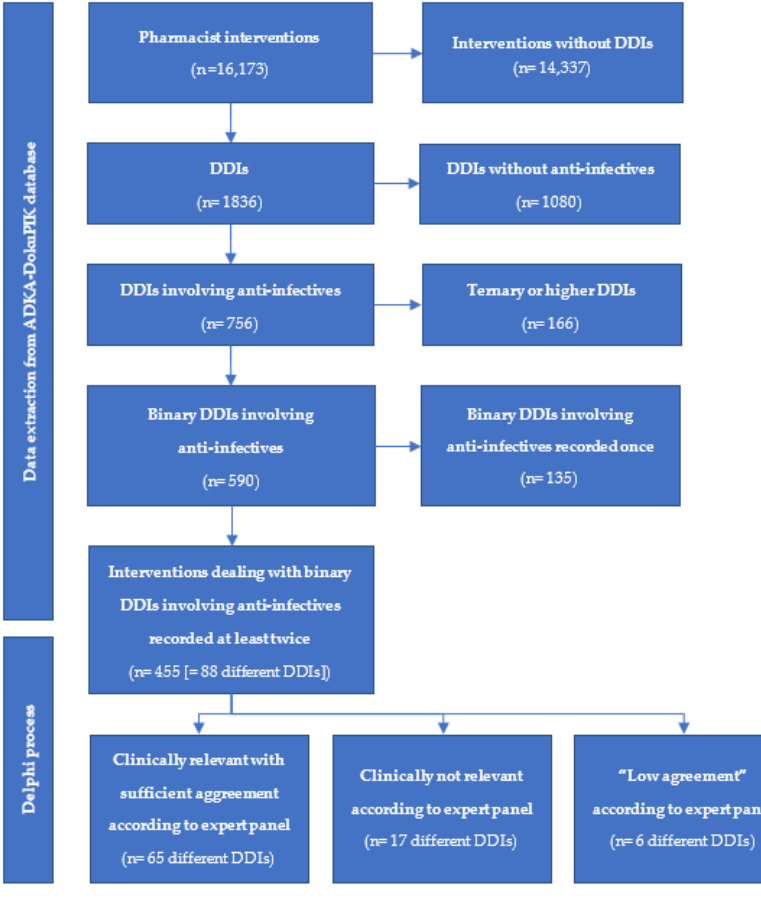
Figure 1. Selection of binary DDIs out of pharmacist’s interventions on German intensive care units recorded in the ADKA-DokuPIK database. DDI = drug–drug